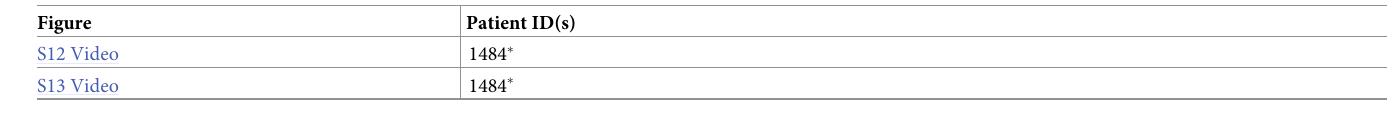
trend with nucleus size (Fig 7F and 7G). Together these data indicate that enlarged LA cells minimally maintain their protein and organelle homeostasis, scaling it as a function of cell size. These results contradict the notion that these enlarged cells are only swollen or senescent and hints at their higher functional output.